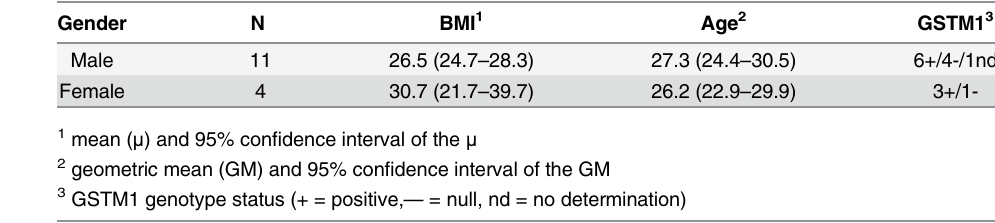
Table 1. Demographics of study participants for selected samples.